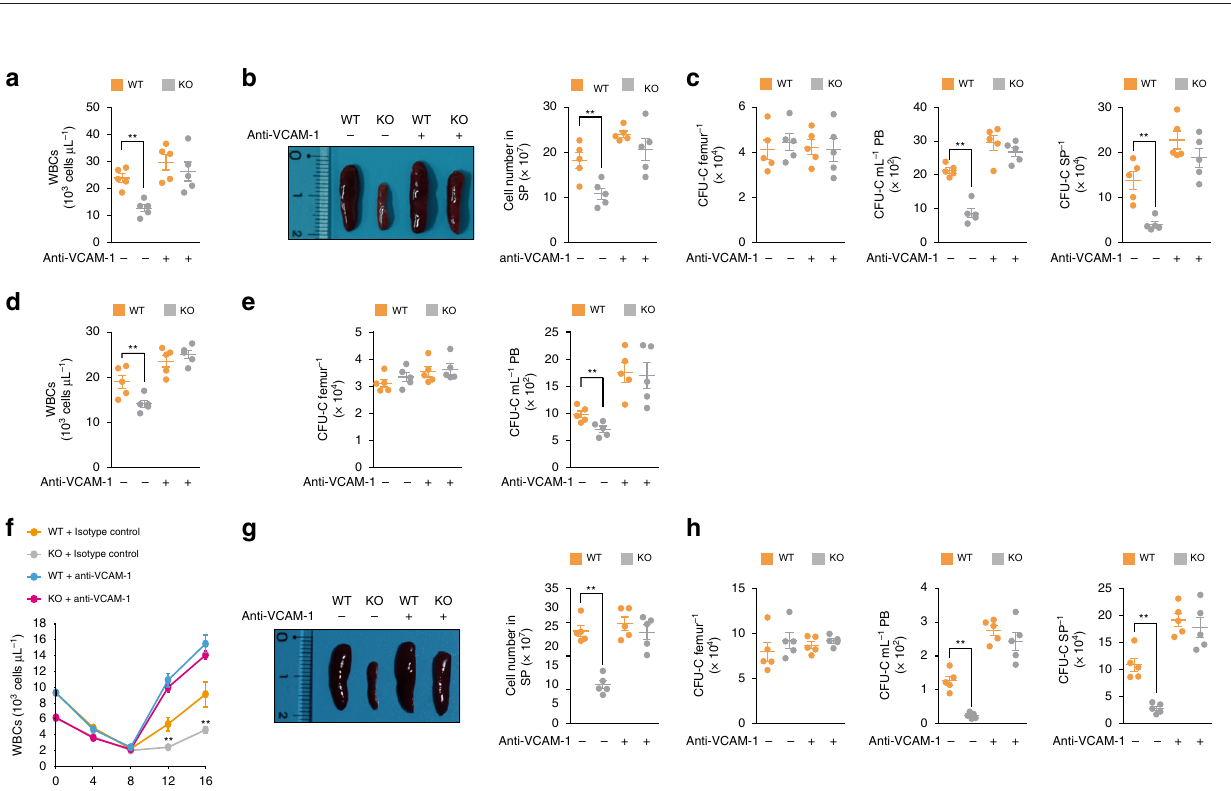
Fig. 7 Blocking the interaction between VCAM-1 and VLA-4 restores steady-state HSPC mobilization in KO mice. a Relative ratio of migrated WT LSK cells (LSK) through WT or KO BMSCs in the presence of anti-VLA-4 Ab and/or anti-VCAM-1 Ab. n = 5 per group. Statistical signi fi cance was assessed by two- tailed Student ’ s t -test. * P < 0.05; ** P < 0.01. b Relative ratio of adhered WT or KO LSK to KO BMSCs in the presence of anti-VLA-4 Ab and/or anti-VCAM- 1 Ab. n = 5 per group. Statistical signi fi cance was assessed by two-tailed Student ’ s t- test. * P < 0.05; ** P < 0.01. c , d CFSE-labeled LSK cells from WT mice